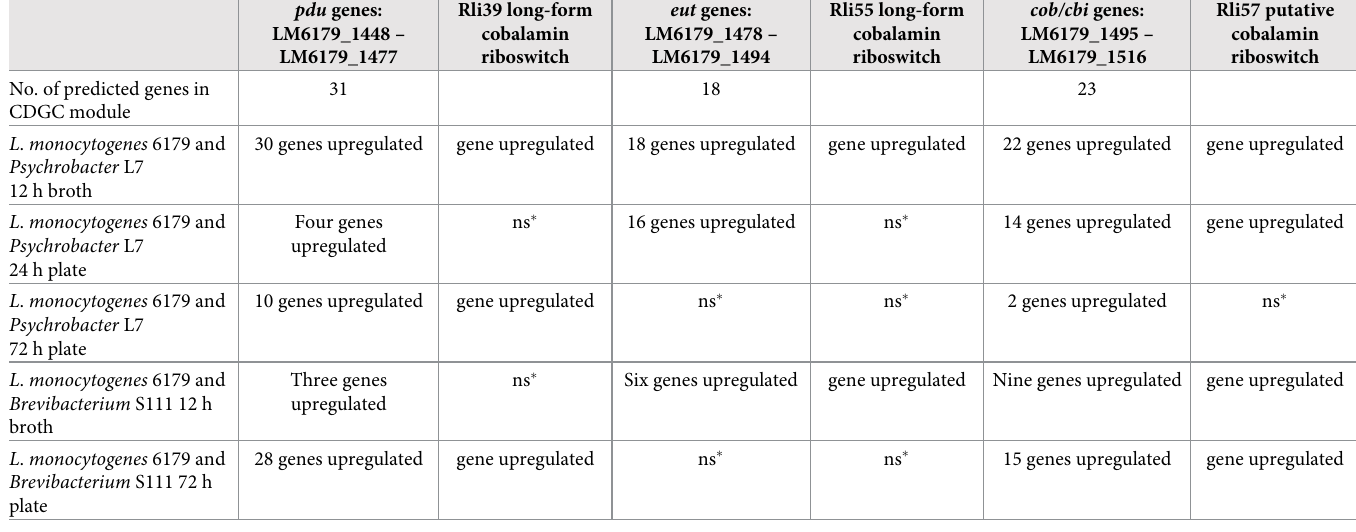
Rli57 putative cobalamin riboswitch